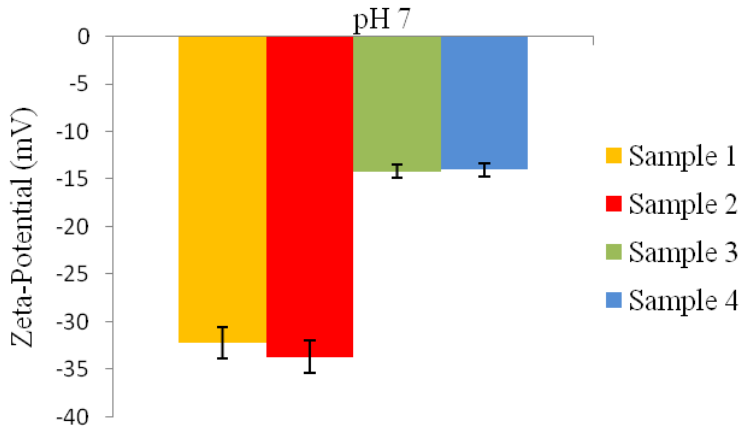
Figure 6. Zeta-potential values of P(3HB) microspheres fabricated using different conditions (Table 1) at pH 7.